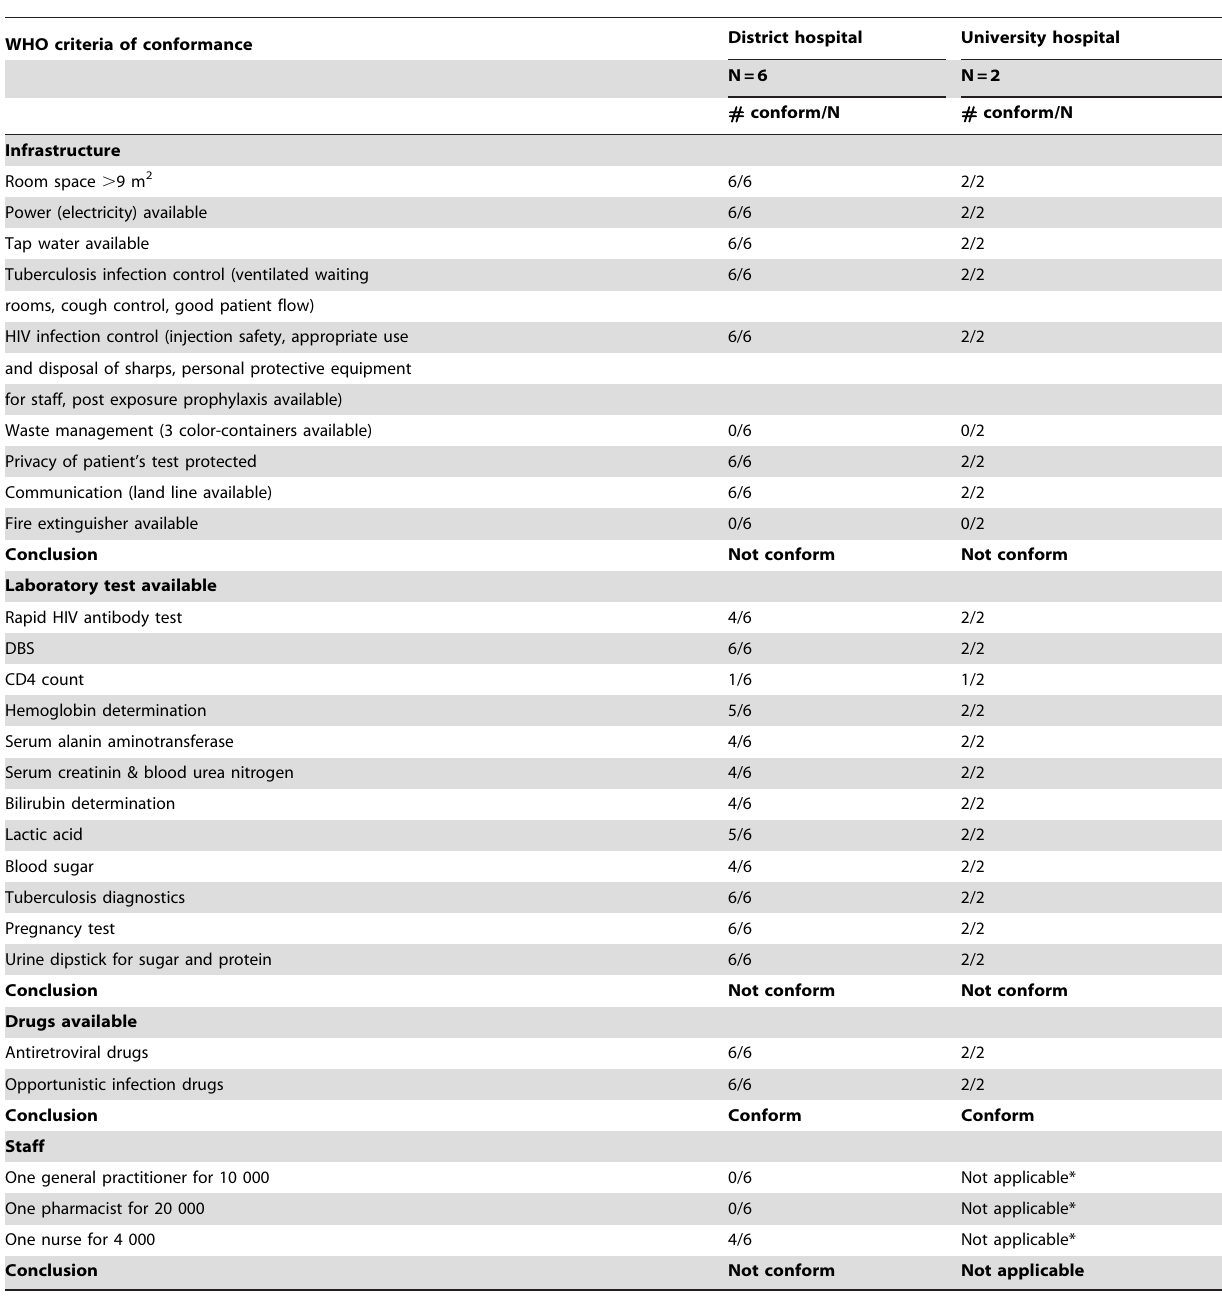
Table 3. Conformance of Ouagadougou hospitals according to WHO standards, in 2010.